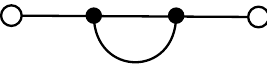
Fig. 8: The dmt-string ˆ D 2